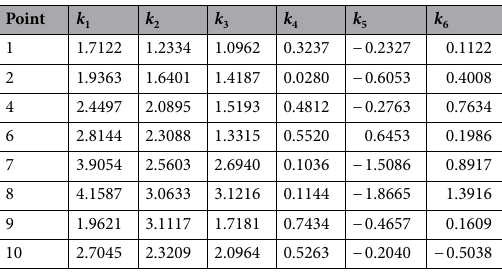
Table 3. Lateral stress coefficient k i for six stress components.